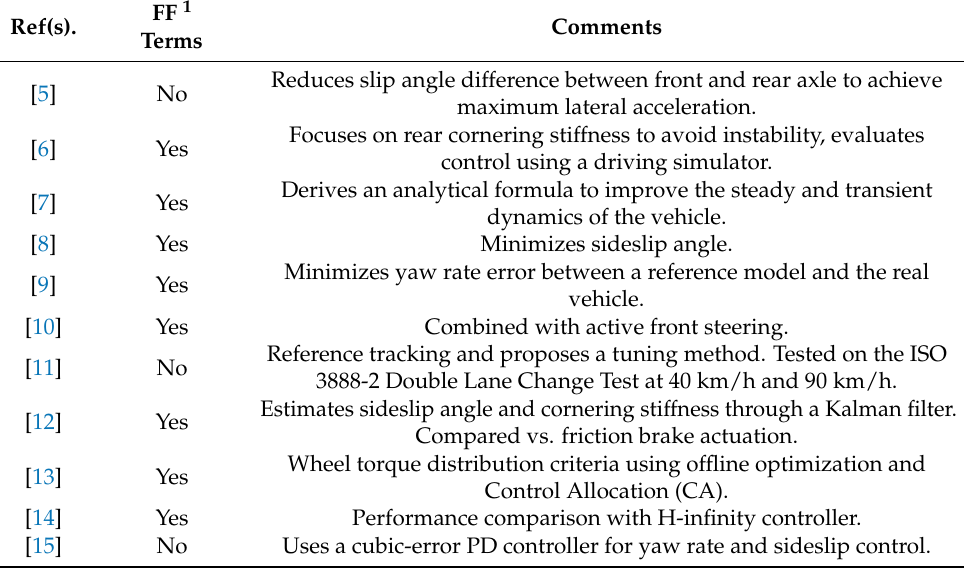
Table 1. Proportional Integral Derivative (PID) controllers in the literature on Direct Yaw Moment Control